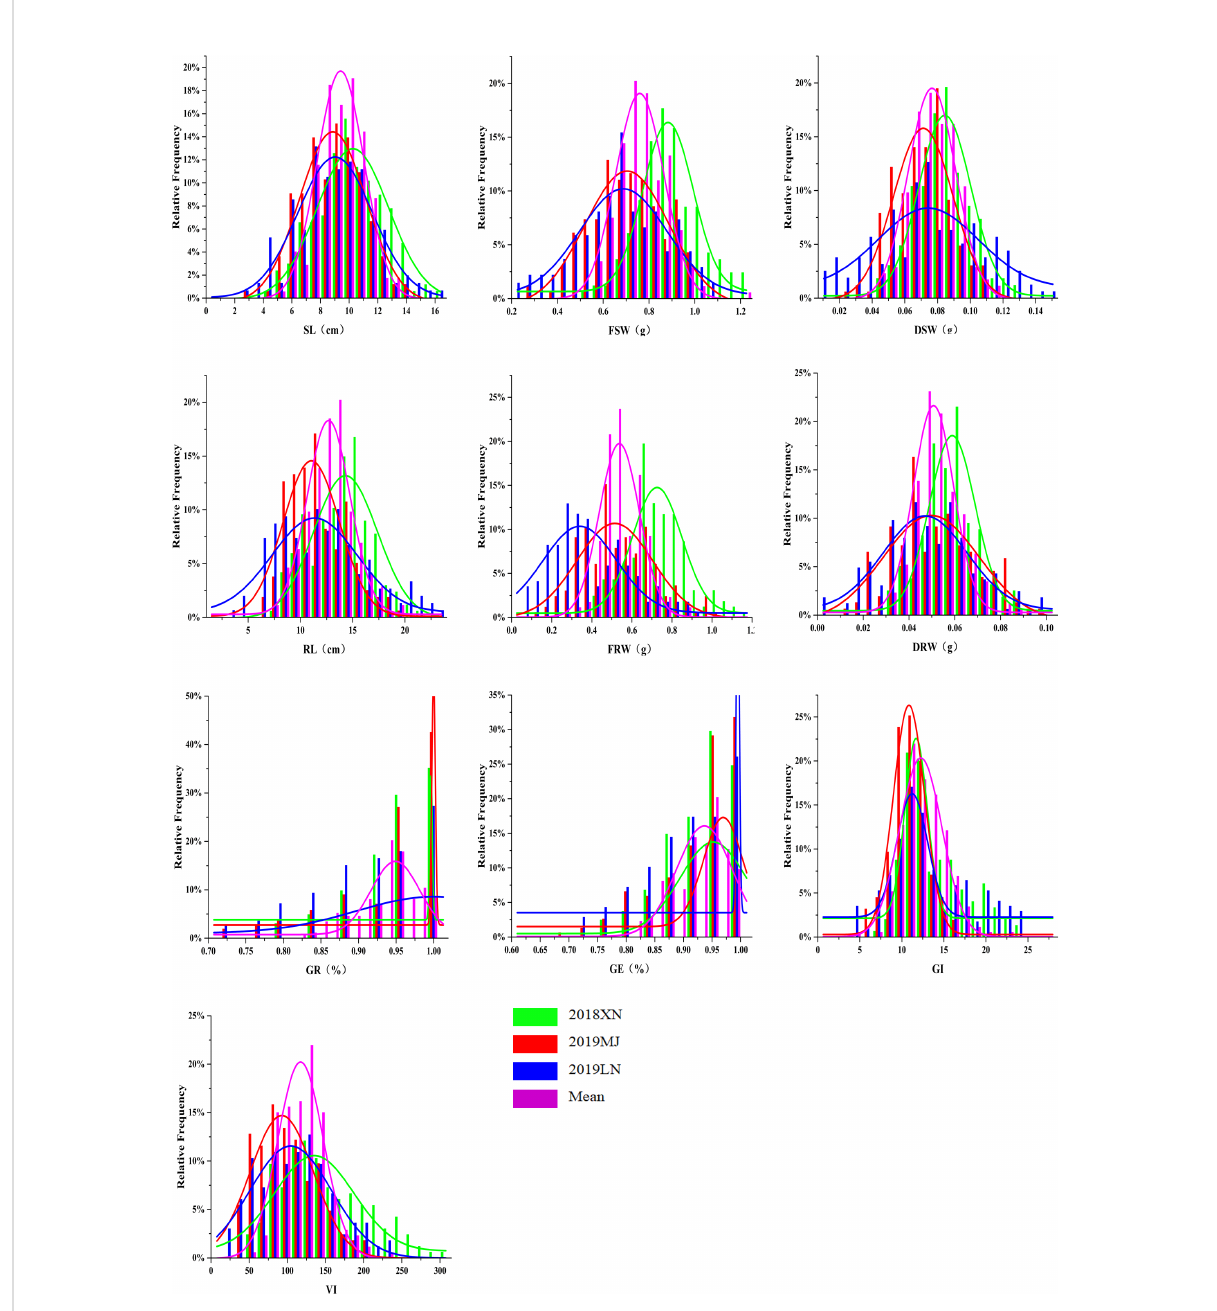
FIGURE 2 Frequency distribution for seed vigor related traits in DH population in three environments and mean values. Green, red, blue and purple represent 2018XN, 2019MJ, 2019LN and mean value, respectively. 2018XN, 2019MJ, 2019LN and mean represent data from the Farm of Henan University of Science and Technology in 2018-2019, Mengjin County in 2019-2020, Luoning County in 2019-2020, and mean values of three environments, respectively. SL, Shoot Length; RL, Root Length; FSW, Fresh Shoot Weight; FRW, Fresh Root Weight; DSW, Dry Shoot Weight; DRW, Dry Root Weight; GR, Germination Rate; GE, Germination Energy; GI, Germination Index; VI, Vigor